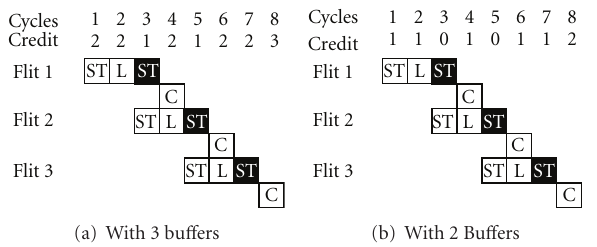
Figure 3: Timing diagram of two di ff erent bu ff er configurations. ST—switch traversal delay, L—link latency, C— credit